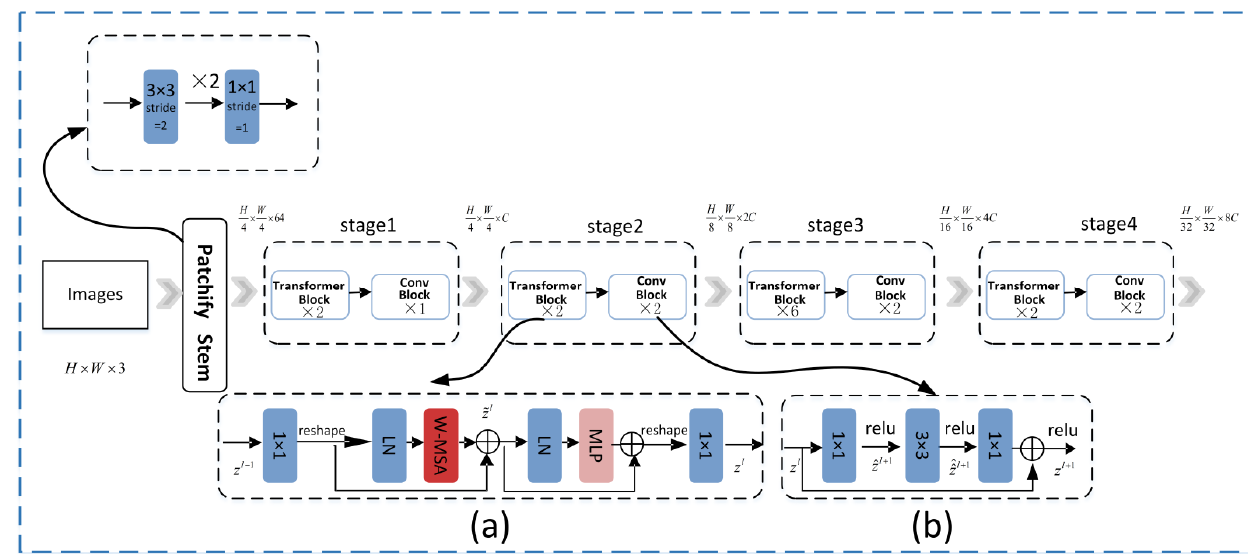
Figure 2. The architecture of a TransConvNet (TransCovNet-T), which consists of Patchify Stem and four stages, each stage contains a different number of transformer blocks and conv blocks; ( a ) the architecture of the transformer block; W-MSA is multi-head self-attention with windowing configurations; MLP and LN are multilayer perceptron layer and layer normalization layer, respectively; ( b ) the architecture of conv block.